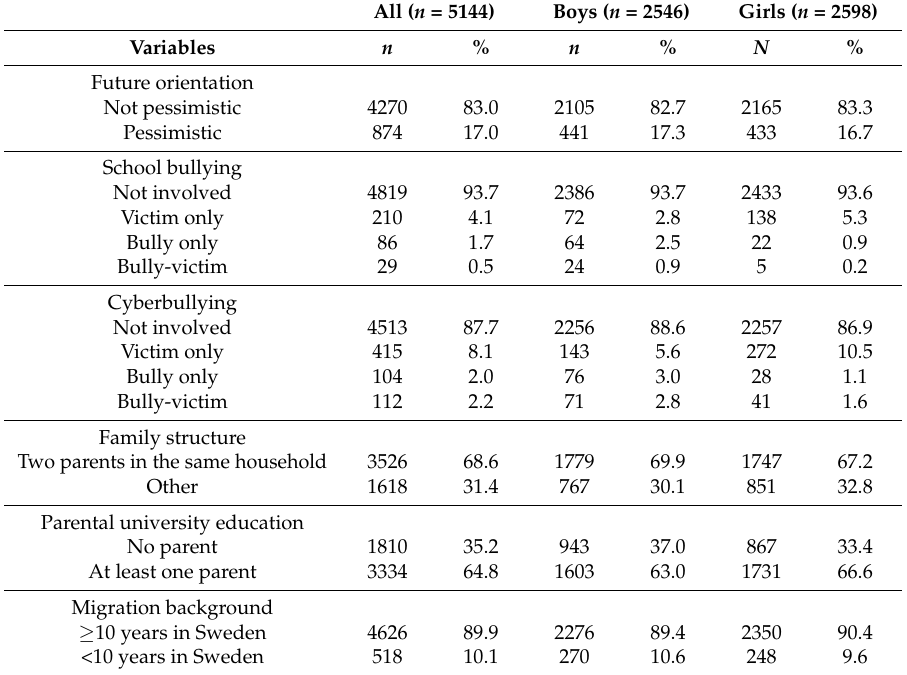
Table 1. Descriptives, n = 5144.